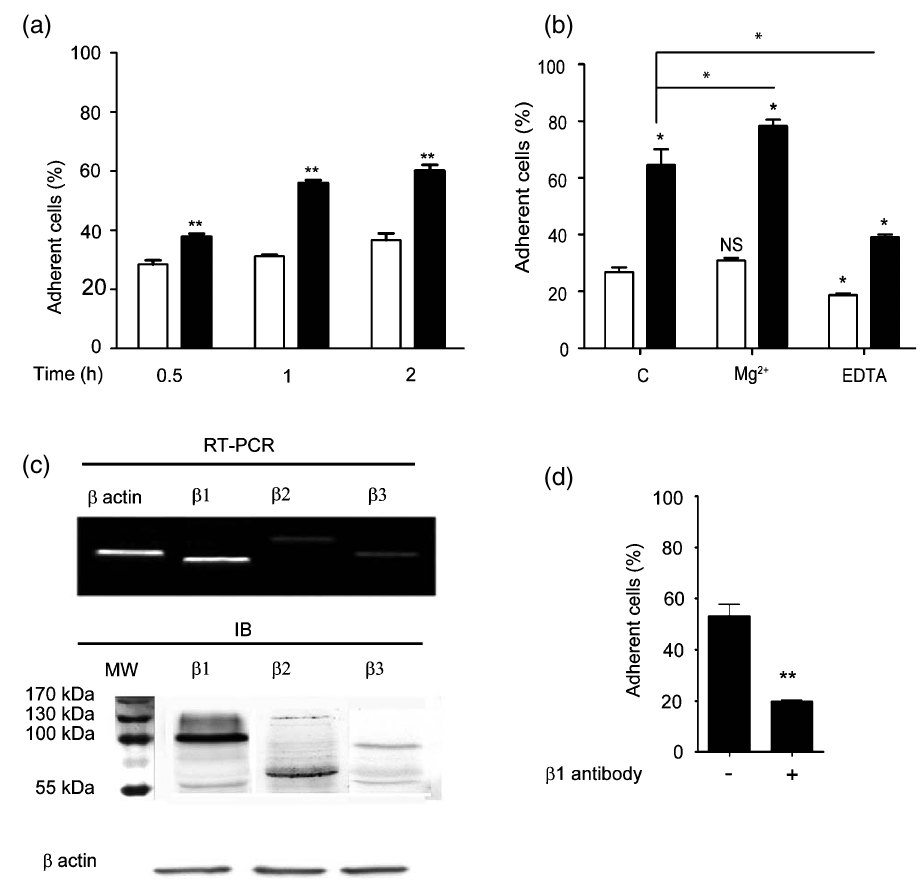
Fig. 1. L1210 cell adhesion to FN/V peptide is mediated by (cid:1) 1 integrin. a ) 25 × 10 4 L1210 cells were seeded on 1% BSA ( (cid:1) ) or 5 (cid:3) g/cm 2 FN/V peptide ( (cid:2) ) from 0 to 2h. b ) 25 × 10 4 L1210 cells were seeded on 1% BSA ( (cid:1) ) or 5 (cid:3) g/cm 2 FN/V peptide ( (cid:2) ) for 2h in the presence of 5mMMg 2 + or 5mM EDTA. After the incubation period, non-adherent cells were discarded and the percentage of adherent cells was determined byvioletcrystalstaining.Absorbancewasrecordedat600nm.Resultsaremeans ± SEMofthreeindependentexperiments.* P <0.05;** P <0.01 compared to cells adhered to BSA. NS=non significant. c ) mRNA extracted from 3 × 10 6 L1210 cells were submitted to RT-PCR and a representative electrophoretic pattern of amplification products related to (cid:1) 1, (cid:1) 2 and (cid:1) 3 integrin subunits was shown. Whole cell extracts were analysed by 10% SDS-PAGE followed by western blotting using monoclonal anti- (cid:1) 1, (cid:1) 2 or (cid:1) 3 antibodies. d ) 25 × 10 4 L1210 cells treated with 10 (cid:3) g/mL (cid:1) 1 blocking antibody for 30min were seeded on 5 (cid:3) g/cm 2 FN/V peptide for 2h. Cell adhesion was evaluated as described in part a. ** P <0.01 compared to control isotype antibody (10 (cid:3) g/mL).